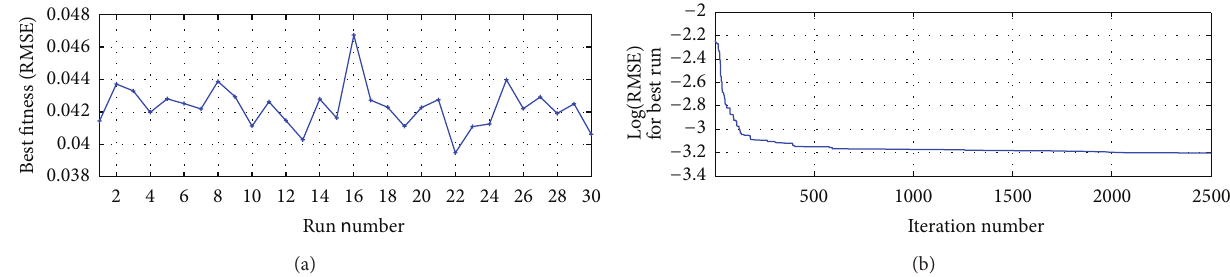
Figure 10: MA-ANN-PSO(9,10,1): (a) run versus fitness for 2500 iterations and (b) iterations number for the best run.